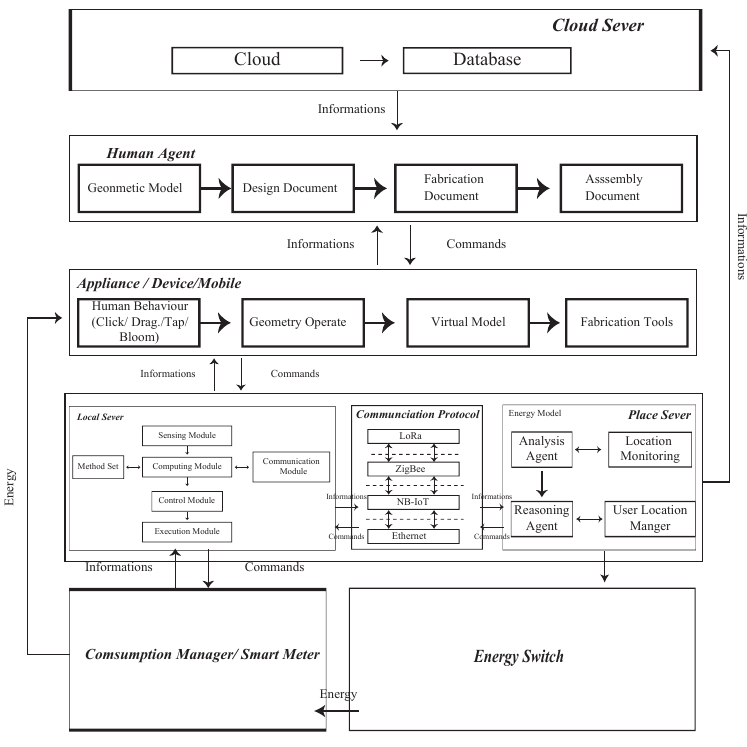
Figure 4. The system structure of this